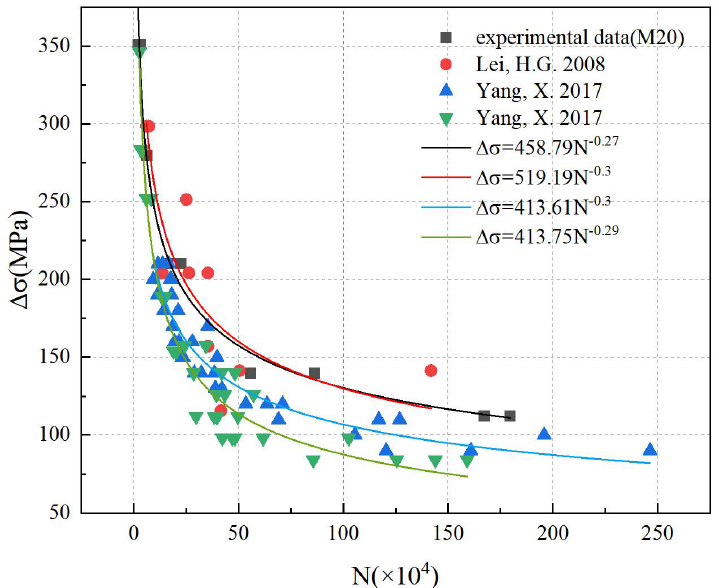
Figure 11. Power regression curves of high-tensile bolts.